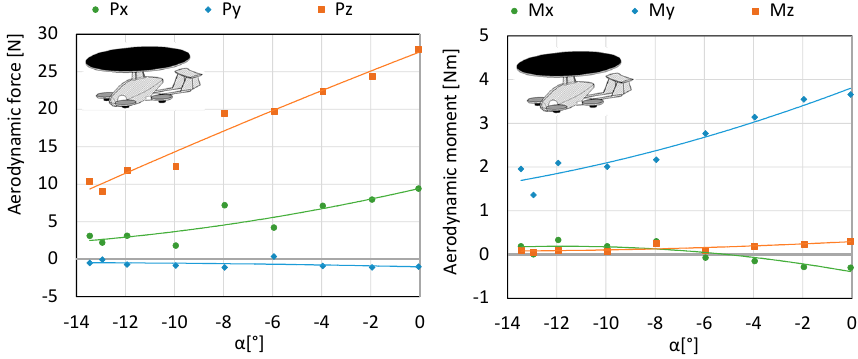
Figure 4. Characteristics of forces and moment of aerodynamic forces for configuration K1.